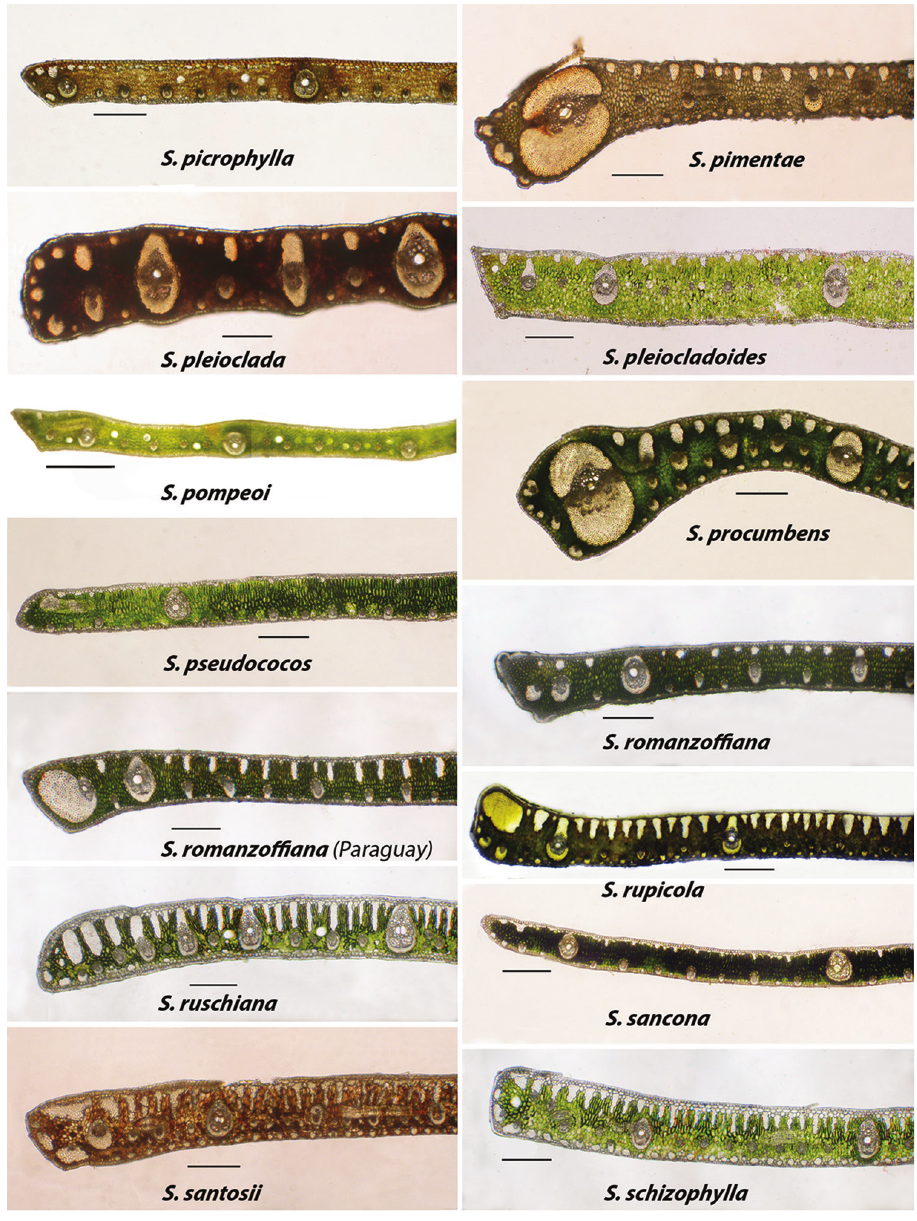
Figure 7. Alphabetically arranged marginal leaflet transections. Syagrus picrophylla to S. schizophylla . Note variation in S. romanzoffiana . Bar scale = 0.25